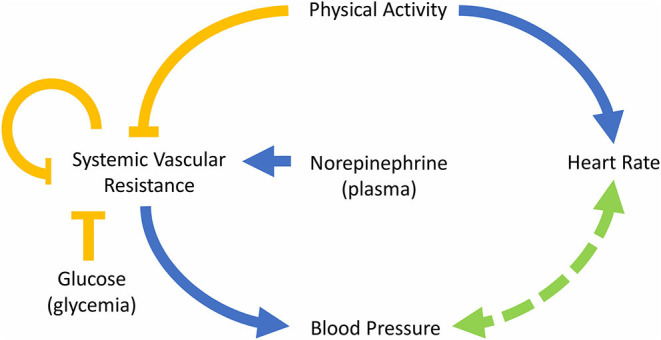
Diagram of the model describing the interactions between the main variables involved in the control of blood pressure. The blue arrows indicate “activation,” the yellow arrows “inhibition” and the arrow with segmented line refers to a mutual regulation.